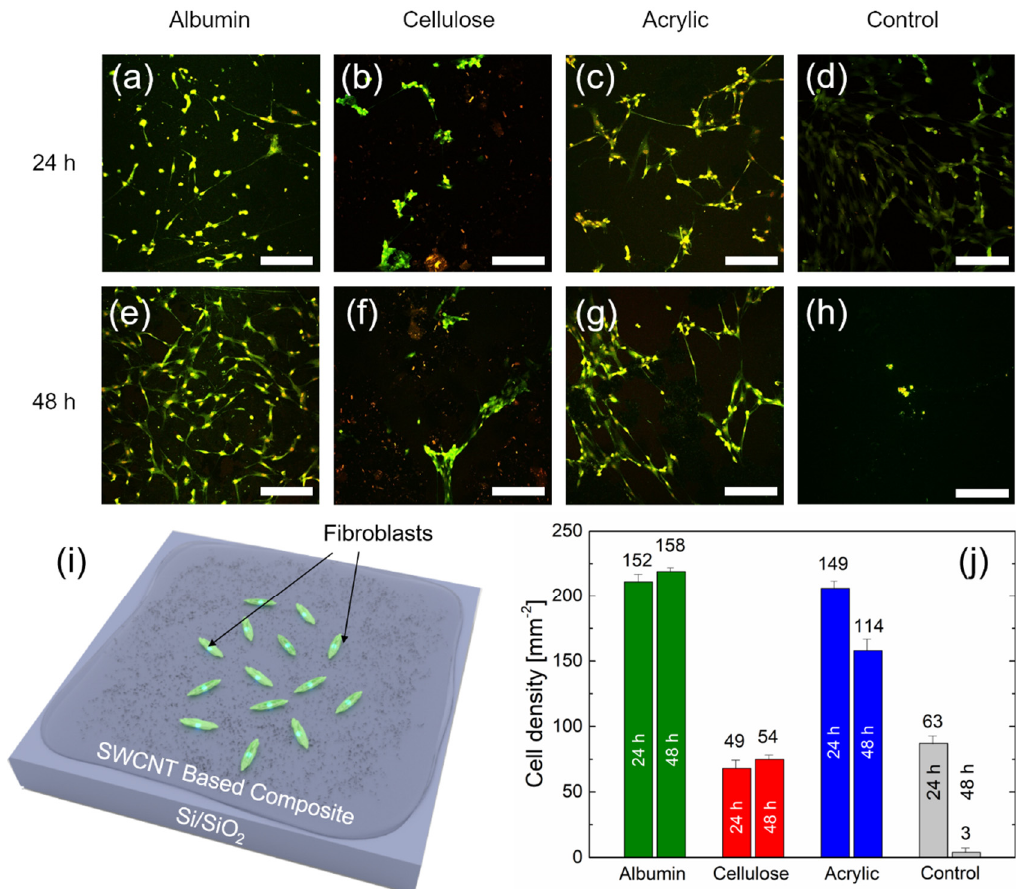
Figure 5. ( a − h ) Examples of fluorescence microscope images (850 µm × 850 µm) of fibroblast cell cultures on Si/SiO 2 substrates with different composites after 24 and 48 h in vitro: albumin ( a , e ), cellulose ( b , f ), and acrylic polymer ( c , g )-based composites mixed with 0.45 wt.% SWCNT and control samples (i.e., Si/SiO 2 substrates without composites) ( d , h ). The scale bar for ( a – h ) is 200 µm. ( i ) Schematic of fibroblasts immobilized on a Si/SiO 2 sample with SWCNT-based composite. The values on the bars in ( j ) represent the total number of live cells averaged over several areas of size 850 µm × 850 µ m (0.7225 mm 2 ). The results from three images on three di ff erent samples for each type of the composite and day in vitro (DIV) were always averaged for the statistics, n =